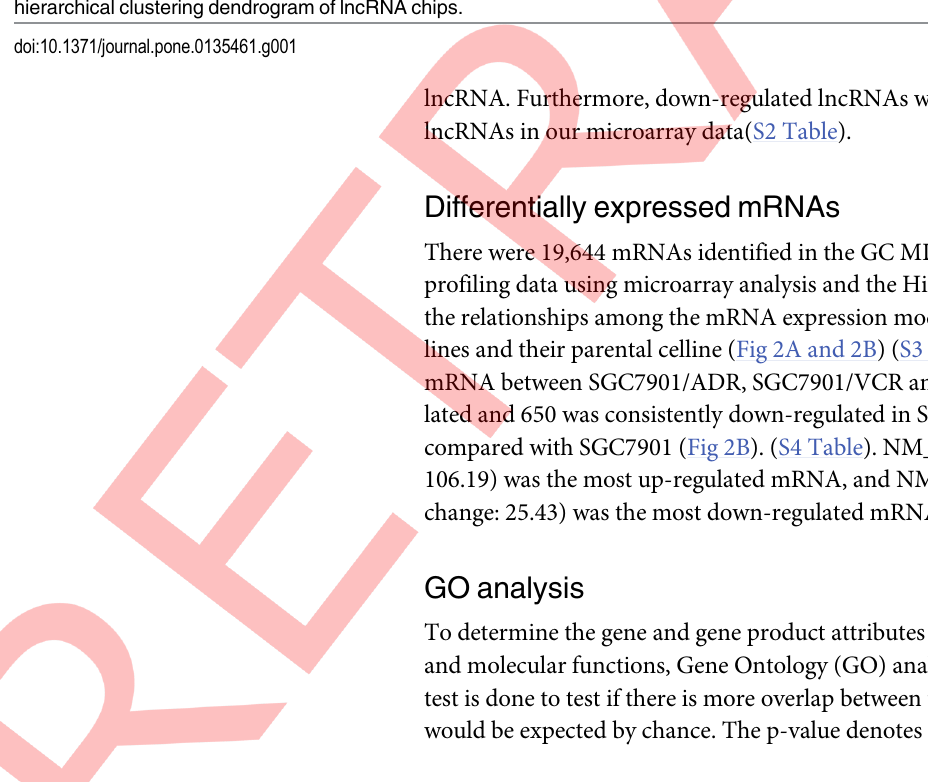
Fig 1. Microarray analysis of MDR-related lncRNA of gastric cancer cell lines. A. The scatterplot of lncRNA expression profile. B. Heat map and hierarchical clustering dendrogram of lncRNA